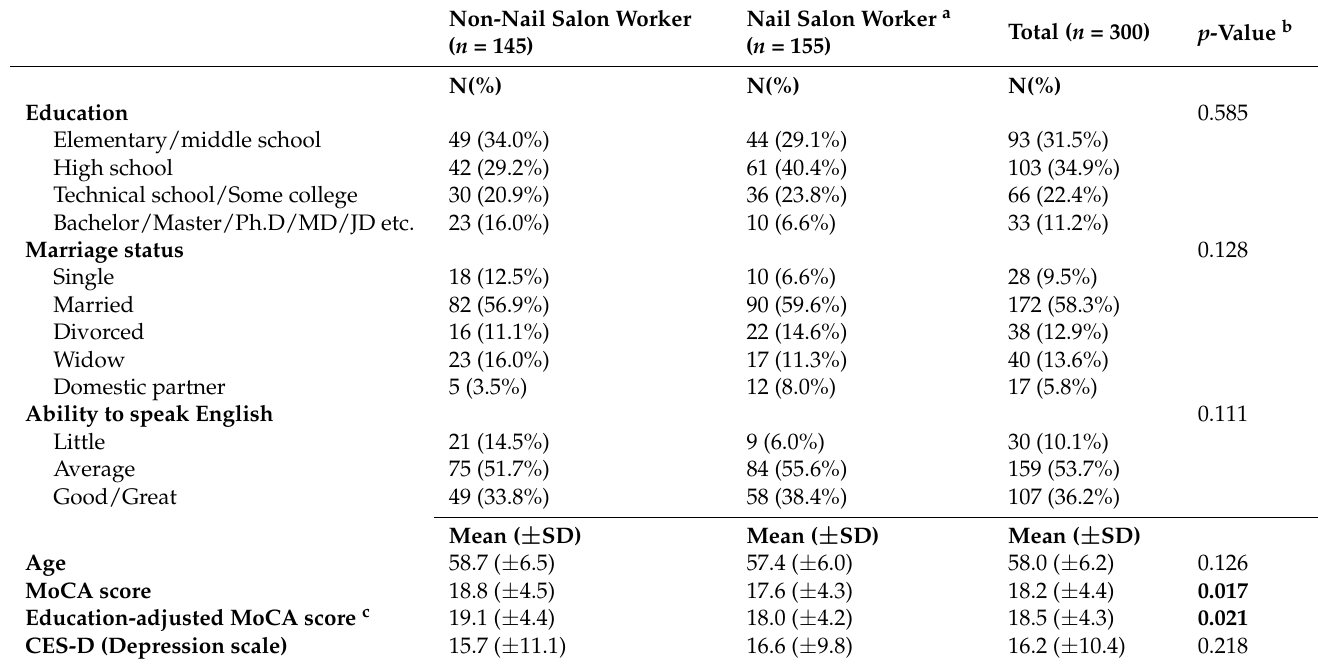
Table 1. Characteristics of participants.